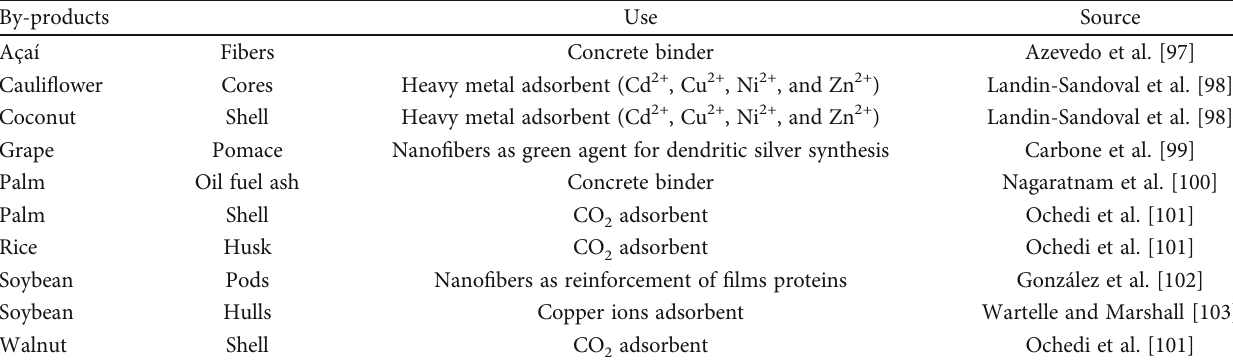
Table 2: By-product applications as nanomaterials, adsorbents, and building